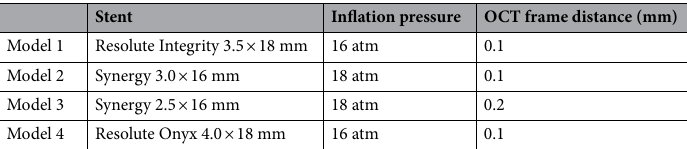
Table 1. Stent types and length measurement.